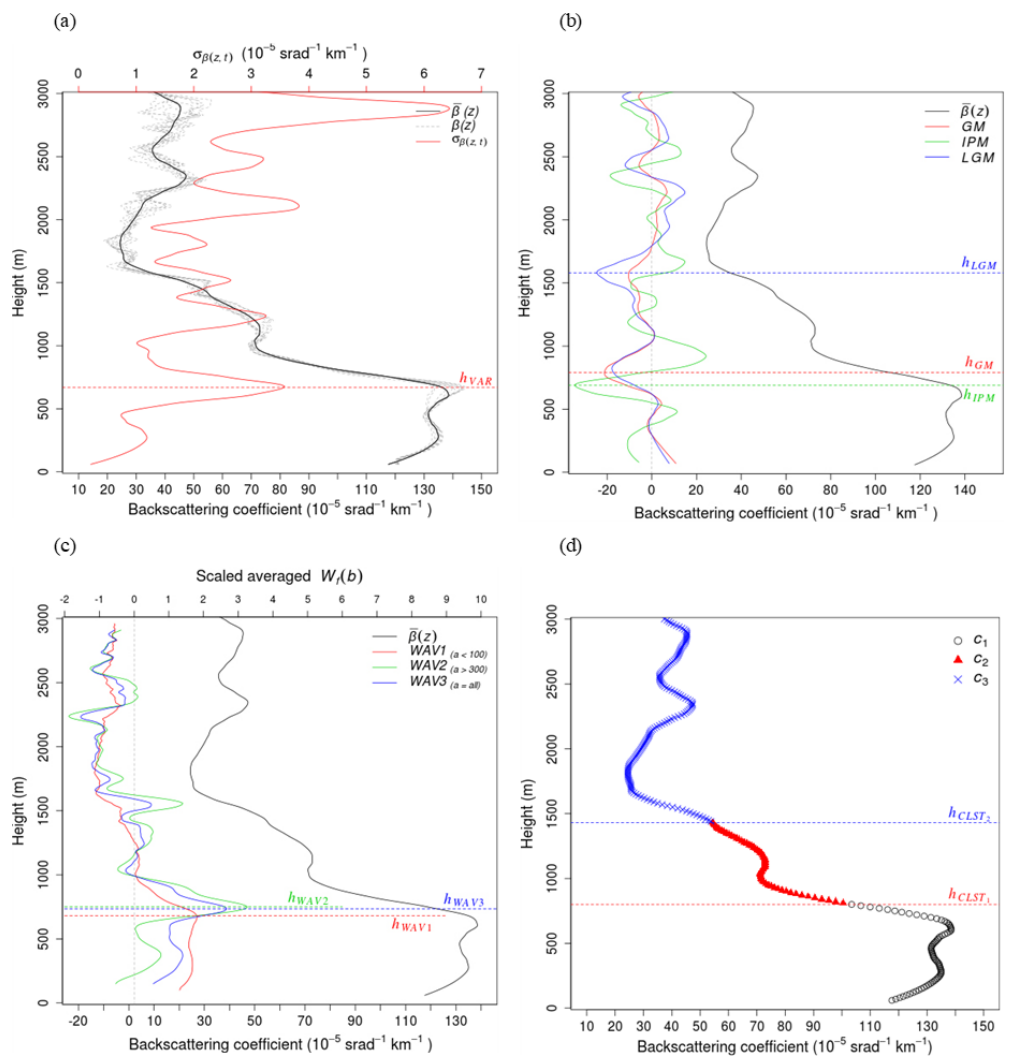
Figure 3. Examples of ABLH estimations. (a) Time-variance method: 10min averaged β (z) (bold black line) and standard deviation ( σ β (red line) at 11:00LST on 23 September 2016; the gray curves are β (z) at intervals of 1min from 10:50 to 11:00LST; h VAR is the ABLH retrieved by the time-variance method. (b) Gradient method (GM, IPM, LGM): the bold black line indicates the 10min averaged β (z) , while the thin solid, dashed, and dash-dotted lines indicate the GM, IPM, and LGM, respectively; the ABLHs ( h GM ,h IMP ,h IPM ) are determined via each method. (c) Wavelet covariance transform method (WAV): the bold black line indicates the 10min averaged β (z) , while the thin solid, dashed, and dash-dotted lines indicate that of WAV1, 2, and 3, respectively; and h WAV1 , h WAV2 , and h WAV3 denote ABLHs, the peaks in each WAV profile. (d) The k -means clustering analysis method: black circles, red triangles, and blue “ × ” marks represent the different clusters, while the boundaries of the clusters ( h CLST1 , h CLST2 ) denote the